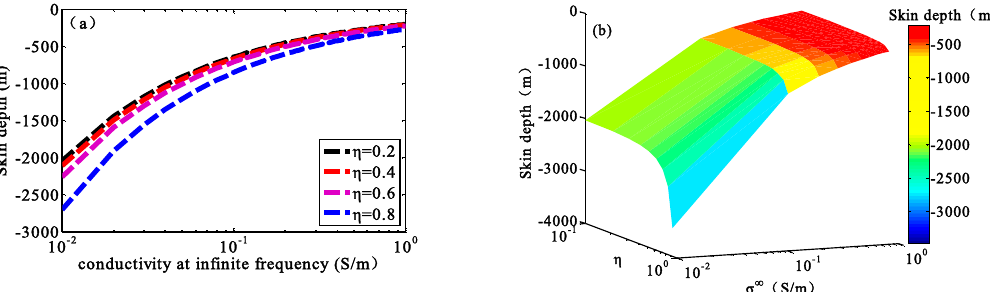
Figure 8. The effect of the conductivity at infinite frequency and the chargeability on the skin depth (( a ) 2D curve, ( b ) 3D view).